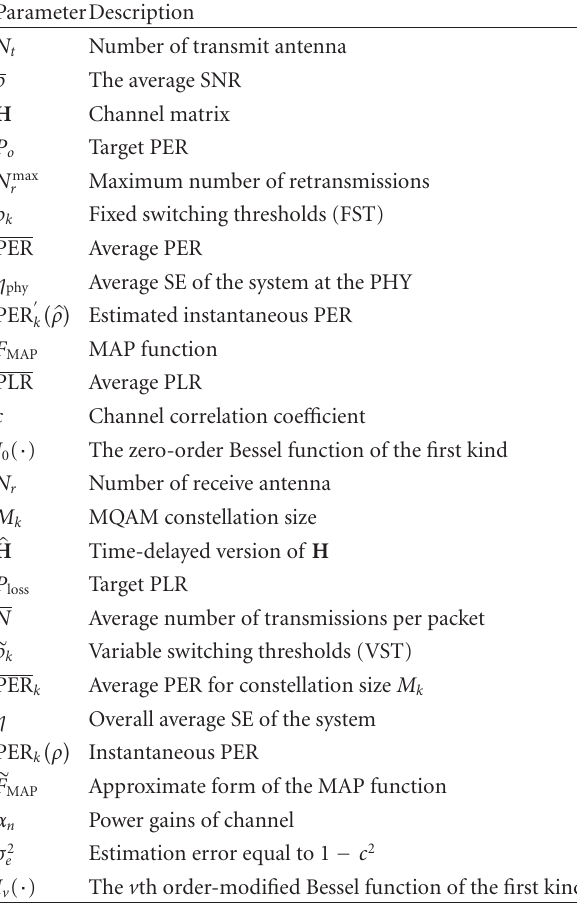
Table 1: Parameter